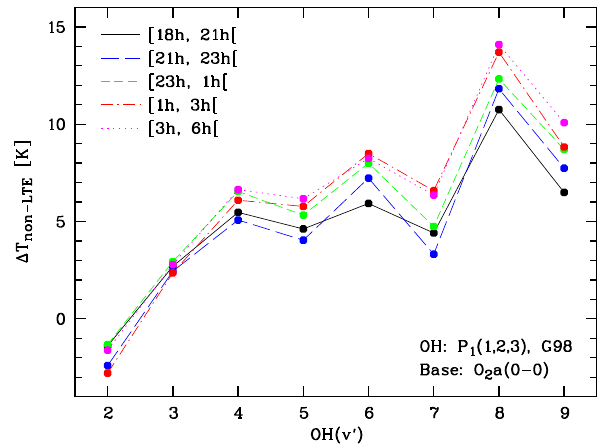
Figure 16. Same plot as Fig. 15 except for OH( v (cid:48) = 2) as base for the calculation of (cid:49)T non-LTE . The errors for comparisons of differ- ent nighttime periods and/or v (cid:48) are probably smaller than those of Fig. 15 since temperature correction uncertainties are less critical. The absolute (cid:49)T non-LTE are less